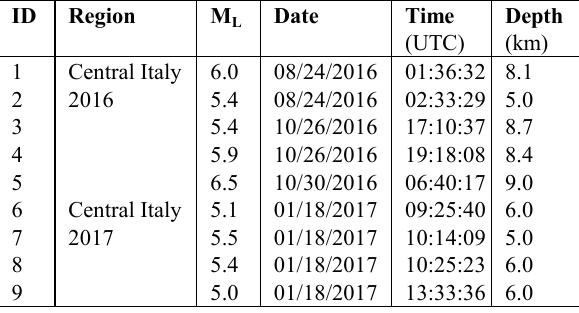
Table 1. Seismic events considered for Central-Italy